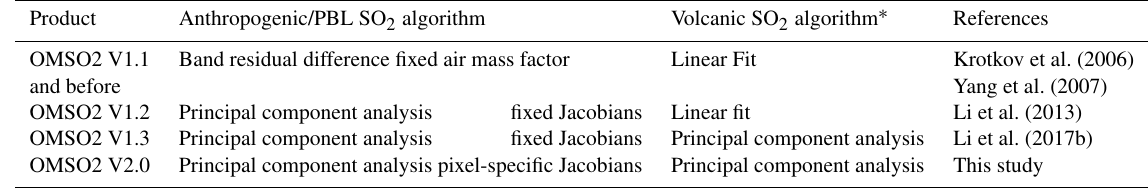
Table 1. Summary of the main characteristics of different versions of the standard OMI SO 2 (OMSO2) product. Product Anthropogenic/PBL SO 2 algorithm Volcanic SO 2 algorithm